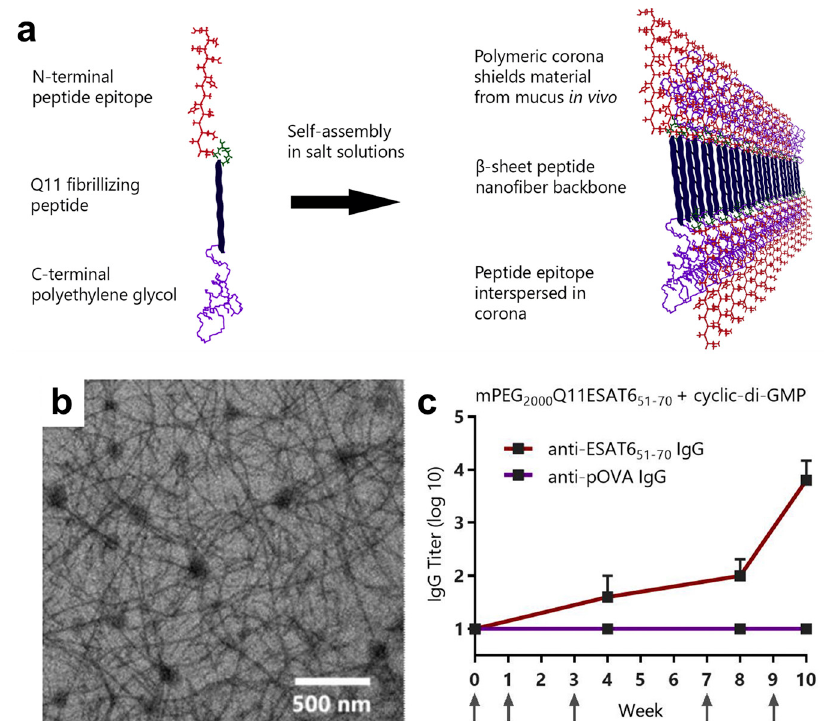
Figure 16. ( a ) Schematic demonstrating functionalized Q11 assembly. The Q11 backbone (navy) self assembles into a β -sheet fiber in ionic solutions. Immunogenic epitopes (red) and PEG motifs (purple) are functionalized to the peptide termini. ( b ) TEM image of self-assembled Q11 fibers conjugated with an ovalbumin epitope, OVA 323–339 . ( c ) Murine model IgG quantification demonstrating successful sublingual immunization against M. tuberculosis with PEG-Q11-ESAT conglomerate. Adapted from [220] with permission from Elsevier.